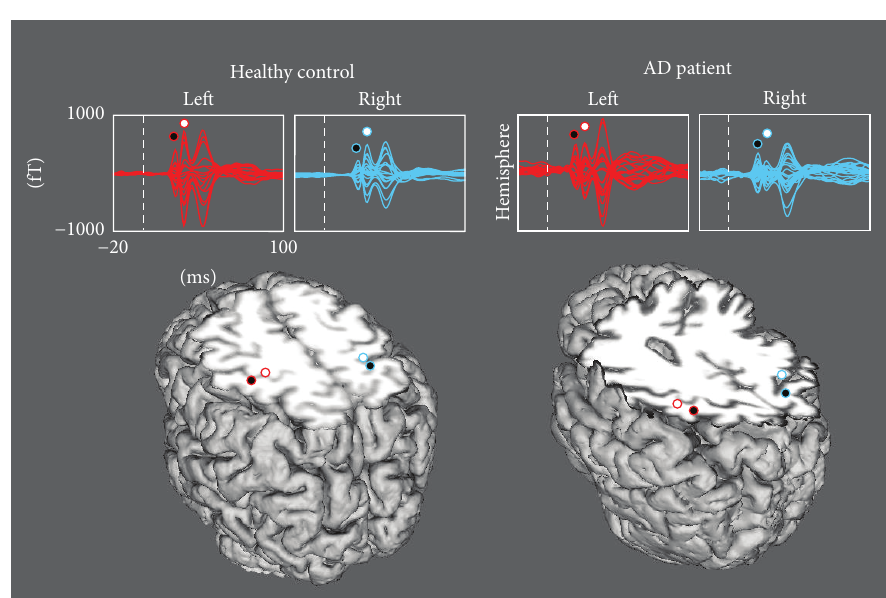
Figure 1: SEF and M20 and M30 ECD positions in a representative healthy control ( F , 68 y.o., MMSE = 29) and an AD patient ( F , 63 y.o., MMSE = 24). (Top) superimposition of all channels in the rolandic region, averaged in the [ − 20, 100] ms period, 0 representing the time of stimulus delivery. The amplitude of the magnetic field is represented in femtotesla (fT) on the 𝑦 -axis; (Bottom) positions of the ECDs explaining the cerebral activation in correspondence to the M20 (black circle) and M30 (white circle) components, projected onto a suitable axial slice after volumetric head reconstruction from individual MR images.